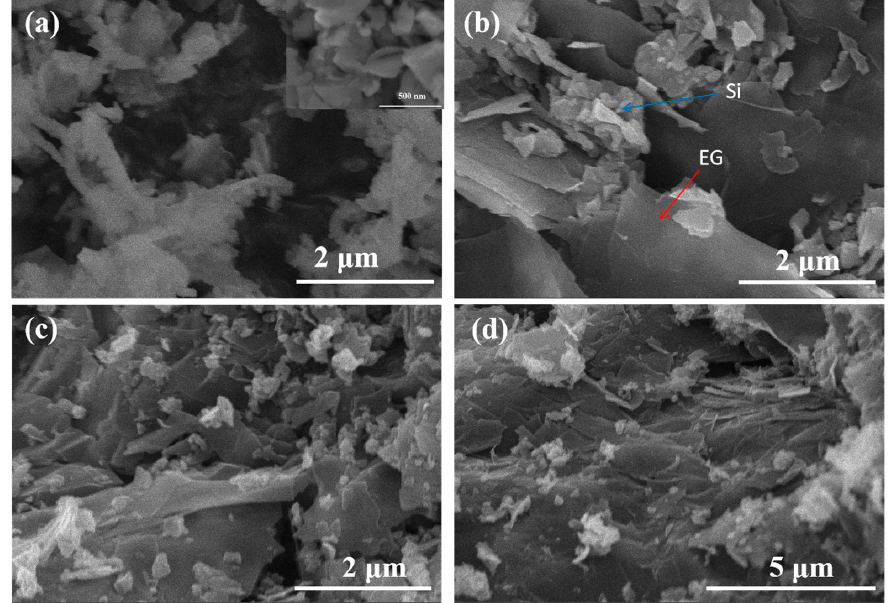
Figure 1. SEM images of ( a ) commercial nano-silicon powder, ( b ) synthesized Si@EG and ( c , d )